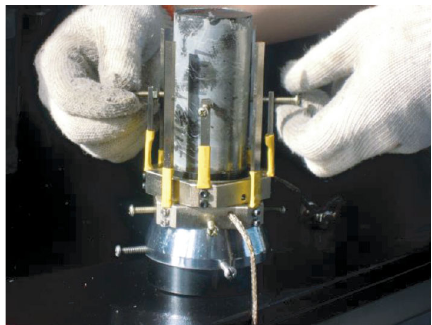
Figure 3: Uniaxial compression test of shale